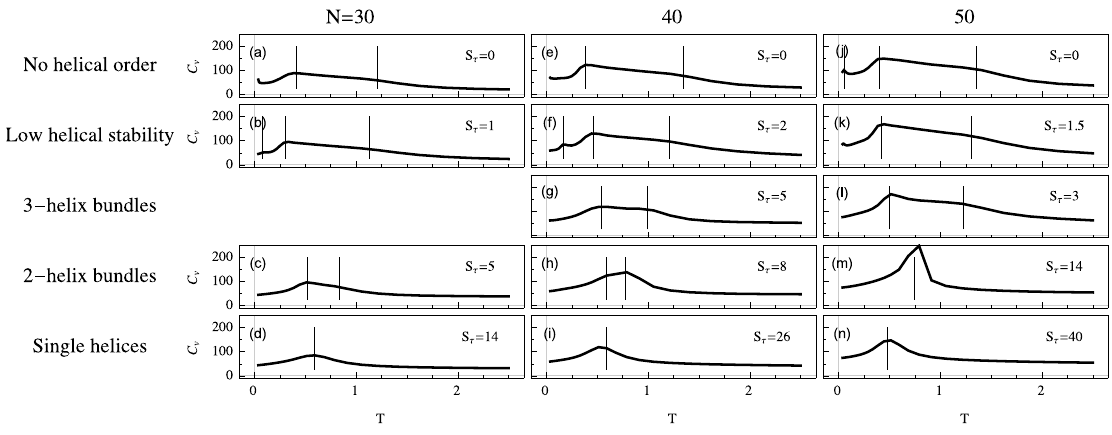
Figure 3. Heat-capacity curves (in units of k B ) as functions of temperature for various system sizes of semiflexible polymers with lengths N = 30, 40, and 50. S τ values are chosen such that lowest-energy structure types coincide in each figure row. Vertical lines mark the locations of enhanced thermal activity represented by peaks and shoulders.